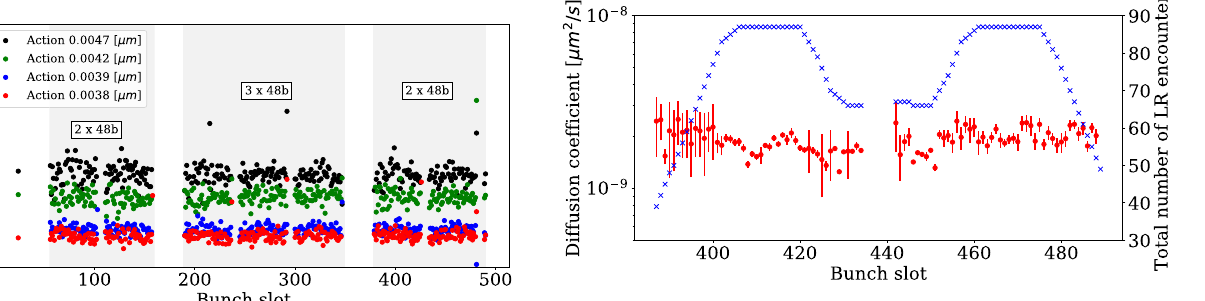
FIG. 14. Bunch-by-bunch diffusion coefficient obtained from dBLM acquisition mode 1 for fill 6052 (details in Table III). The four datasets belong to different steps and, therefore, different actions J . As it was an end-of-fill test, the bunch intensities were significantly lower than nominal.